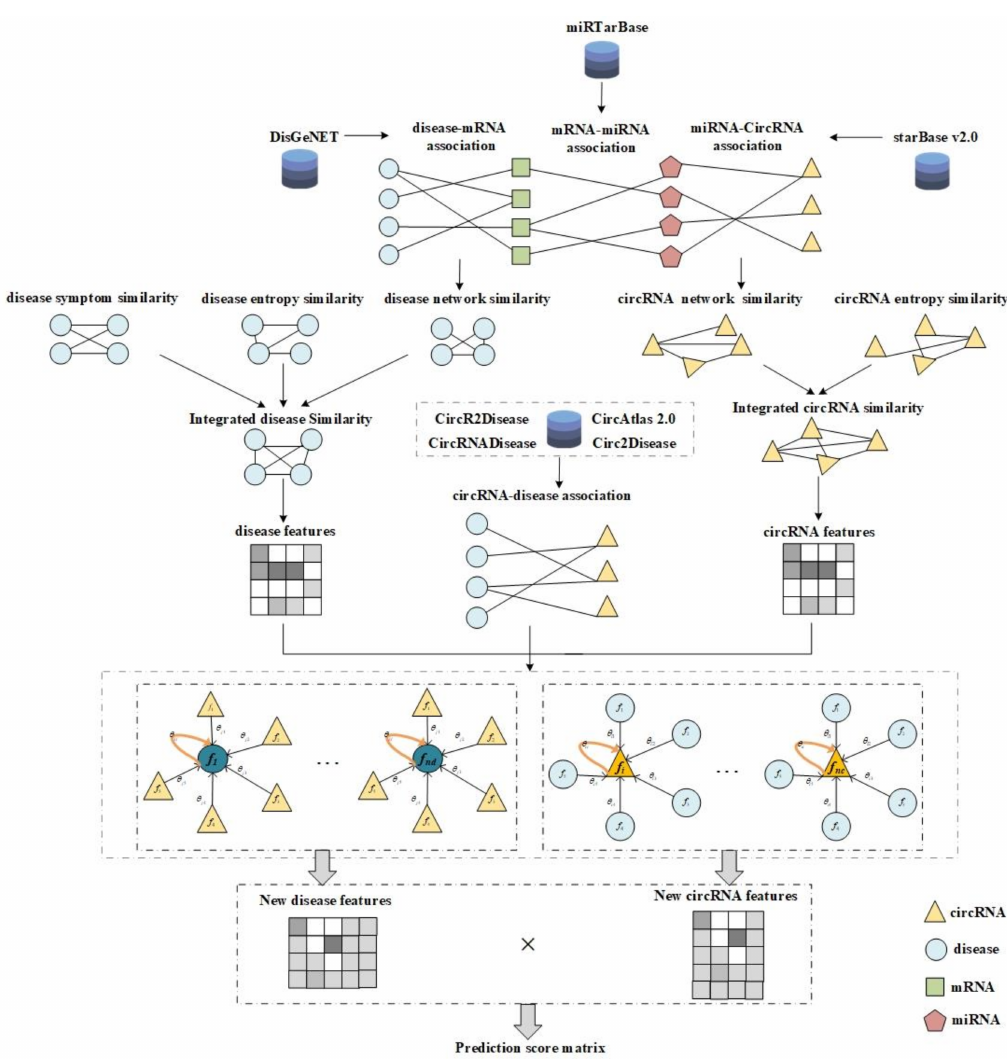
Figure 1. The flowchart of the computational method